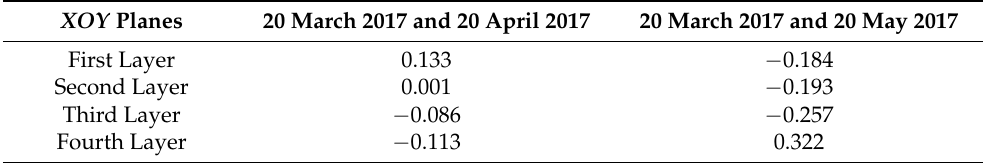
Figure 7. Temperature field cloud map of the second layer on the XOY plane on 10 April 2017. Table 6. The influence of empty warehouse on the temperature correlation on the XOY plane.